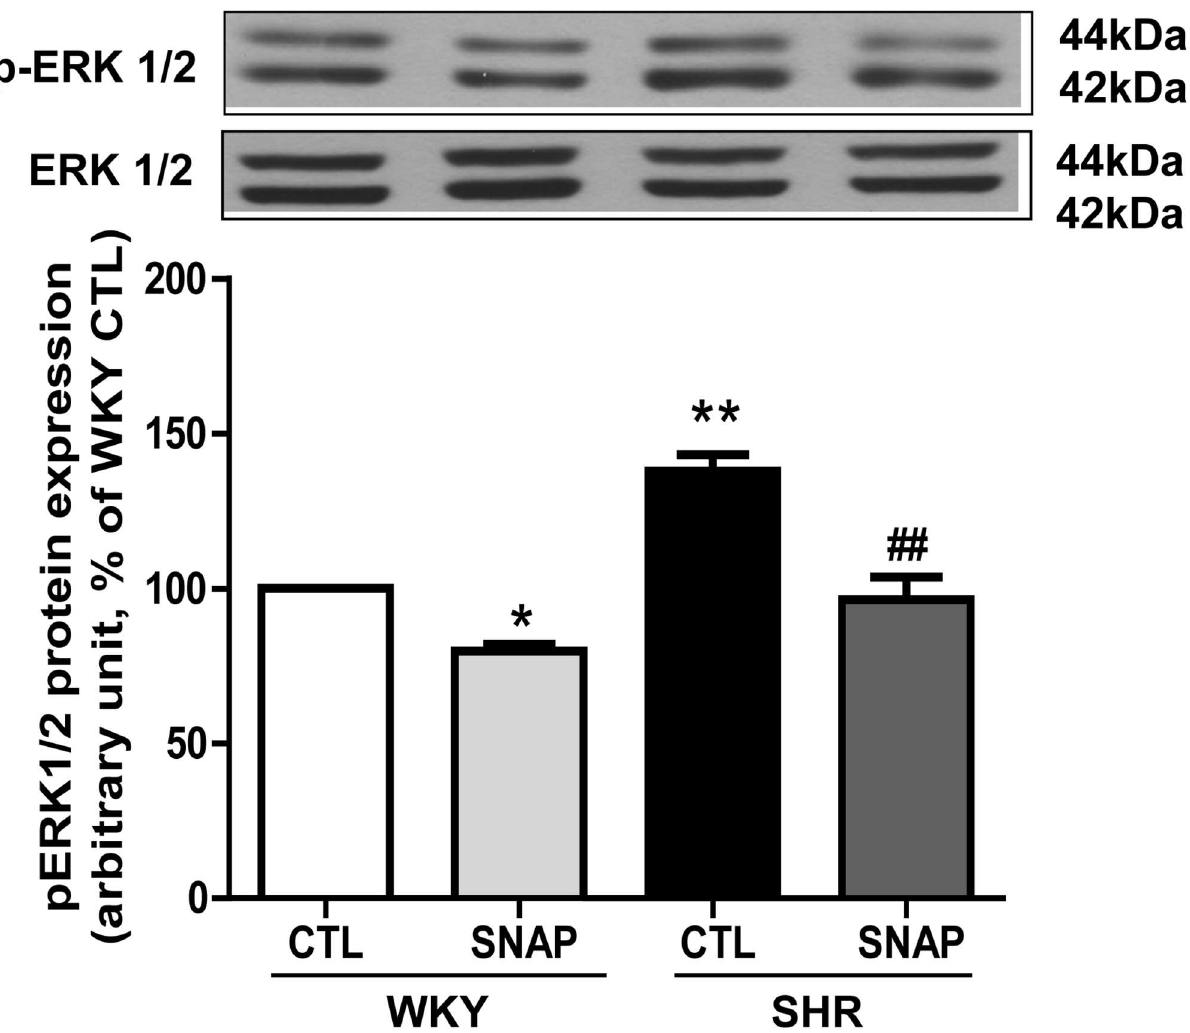
Fig 9. Effect of SNAP on ERK phosphorylation in VSMC from 12-weekold SHR and age-matched WKY rats. ConfluentVSMC were incubatedin the absence(control) or presenceof SNAP (100 μ M) for 24 h. The cell lysates were preparedand subjectedto Western blot analysisusing specific antibodies againstphosphorylated ERK1/2 (upper panels) as describedin the Materials and methods. Quantification of protein bands was done by densitometric scanning(lower panels). The results are expressedas a percentage of the WKY control (CTL), taken as 100%. Values are the mean ± SD of 4 separateexperiments using different cell populationsfrom different animals. * P < 0.05, ** P < 0.01vs WKY CTL group, ## P < 0.001vs SHR CTL